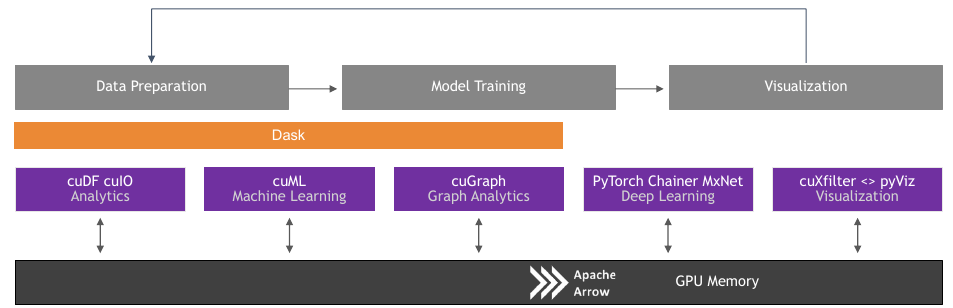
Figure 4. RAPIDS is an open source effort to support and grow the ecosystem of GPU-accelerated Python tools for data science, machine learning, and scientific computing. RAPIDS supports existing libraries, fills gaps by providing open source libraries with crucial components that are missing from the Python community, and promotes cohesion across the ecosystem by supporting interoperability across the